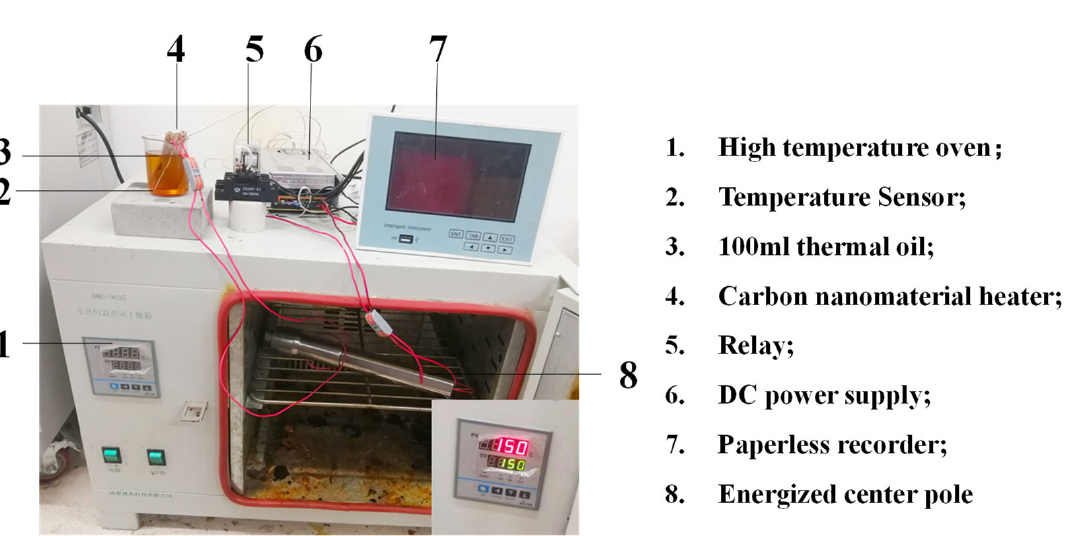
Figure 25. High-temperature test experiment of the conductive center pole. The physical experiment platform is shown in Figure 26.